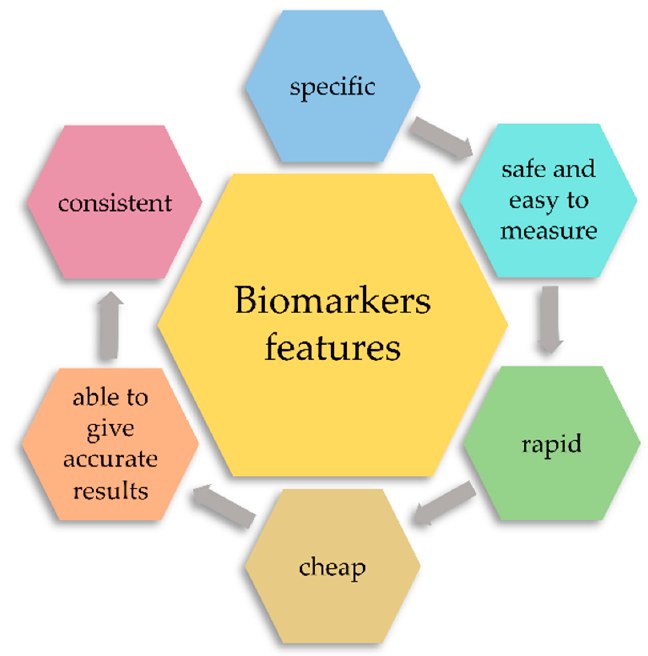
Figure 2. Classification of biomarkers due to the genetic and molecular aspect, the usefulness of biomarkers in diagnostic processes, and